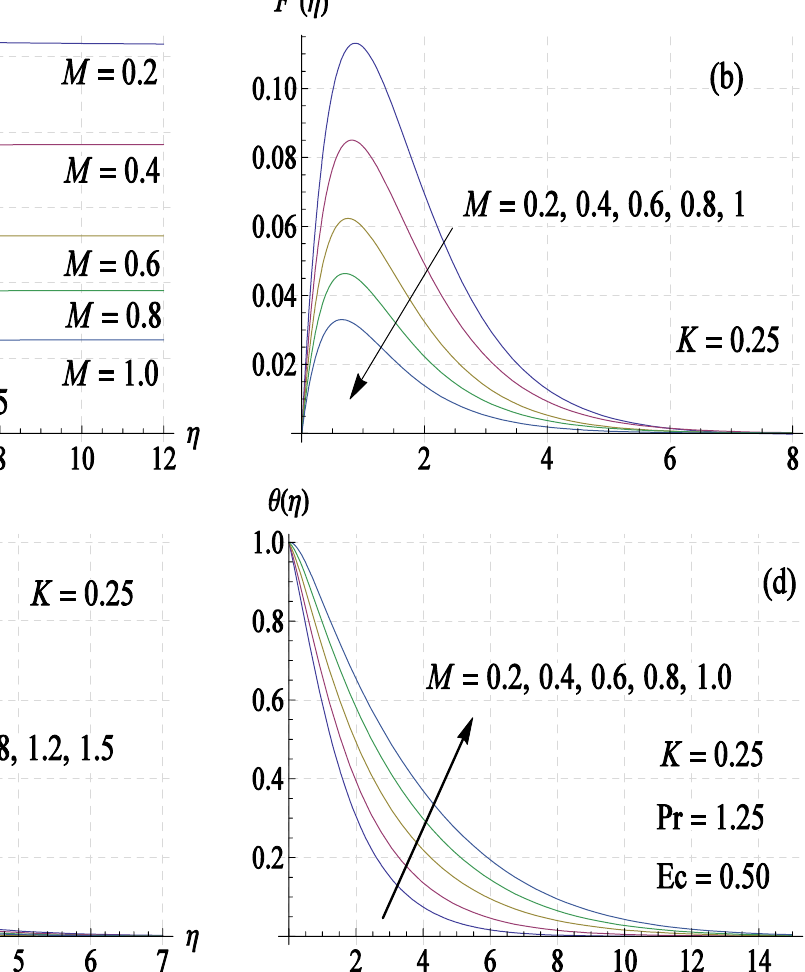
Figure 4. Curves of velocity components and temperature ( θ ) for different values of magnetic interaction parameter M .